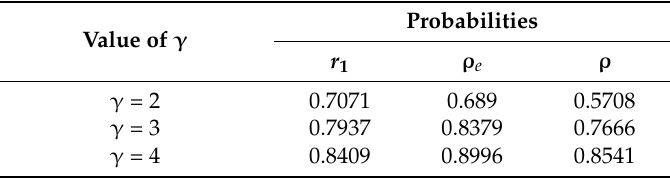
Table 1. Probabilities before and after